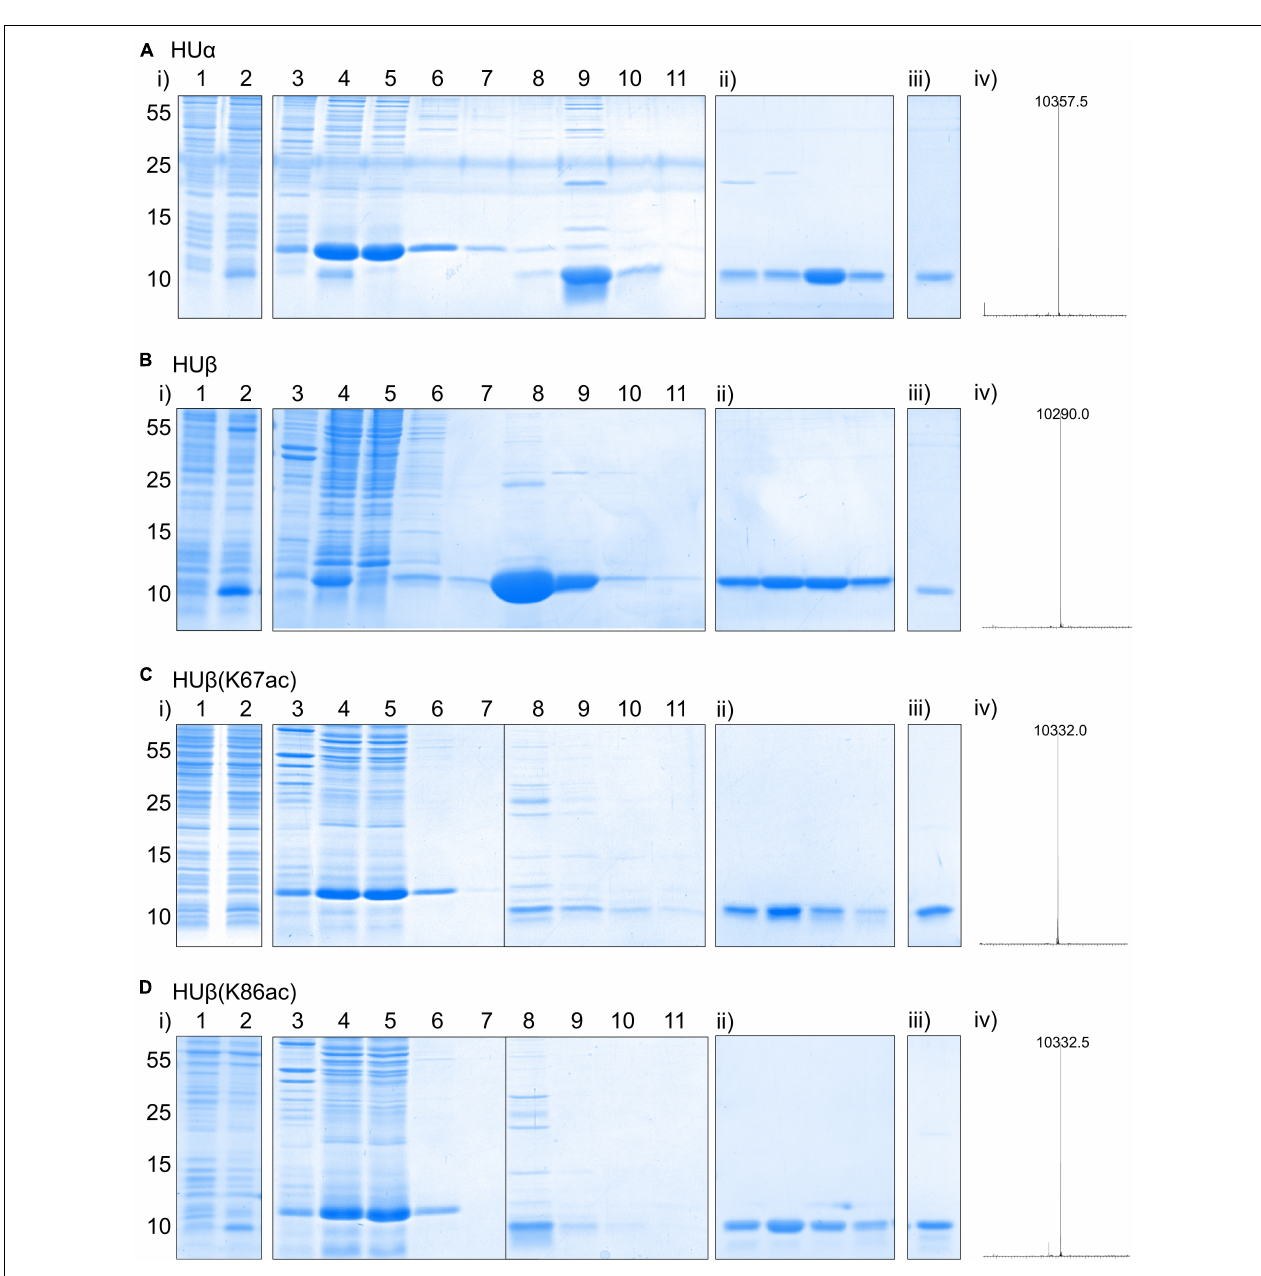
FIGURE 2 | Expression and purification of recombinant E. coli HU α (A) , HU β (B) , HU β (K67ac) (C) , and HU β (K86ac) (D) from E. coli BL21-AI. See section “Materials and Methods” for the detailed procedure. In each panel, expression and nickel affinity purification results are shown in (i) with lane 1 = whole cell lysate before protein induction, lane 2 = whole cell lysate after protein induction for 16 h, lane 3 = insoluble fraction of cell lysate, lane 4 = soluble fraction of cell lysate, lane 5 = flow through from nickel affinity column, lane 6 = flow through from column wash fraction 1, lane 7 = flow through from column wash fraction 2, lane 8 = eluted protein fraction 1, lane 9 = eluted protein fraction 2, lane 10 = eluted protein fraction 3, lane 11 = eluted protein fraction 4. For (ii), purity of four protein fractions eluted from cation exchange chromatography using a NaCl gradient and absorption at 214 nm for detection was analyzed by SDS-PAGE. Results of the pooled purified protein for further studies analyzed by SDS-PAGE and mass spectrometry are shown in (iii) and (iv), respectively. Molecular weights are shown in Dalton (Da), and theoretical values for HU α , HU β , HU β (K67ac), and HU β (K86ac) are 10,357.5, 10,290.7, 10,332.7, and 10,332.7 Da, respectively. Deconvoluted ESI MS spectra are shown in the range of 5–15 kDa. The full-size spectra can be found in Supplementary Figure 1